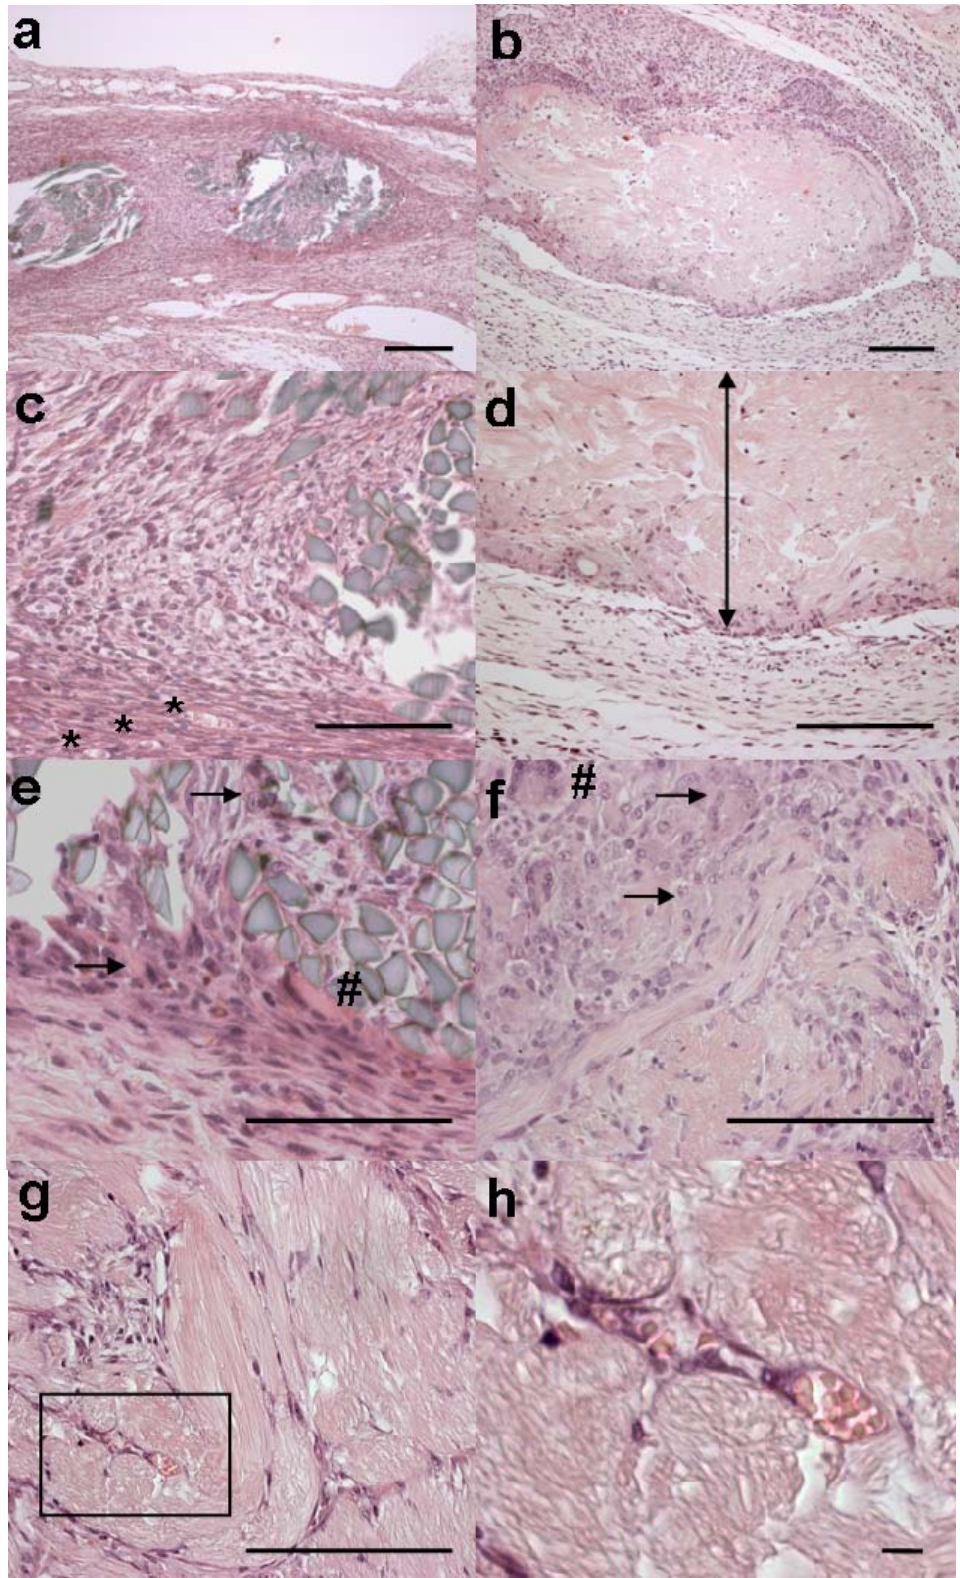
Figure 3. Microscopic appearances of implants. The Mersilk TM implant from rat no. 3 is shown in (a), (c) and (e). 4RepCT fibre implants are shown in (b), (d) and (f) (C3 from rat no. 2), and in (g) and (h) (C2 from rat no. 2). Scale bars are 100 μ m in a-g, and 10 μ m in